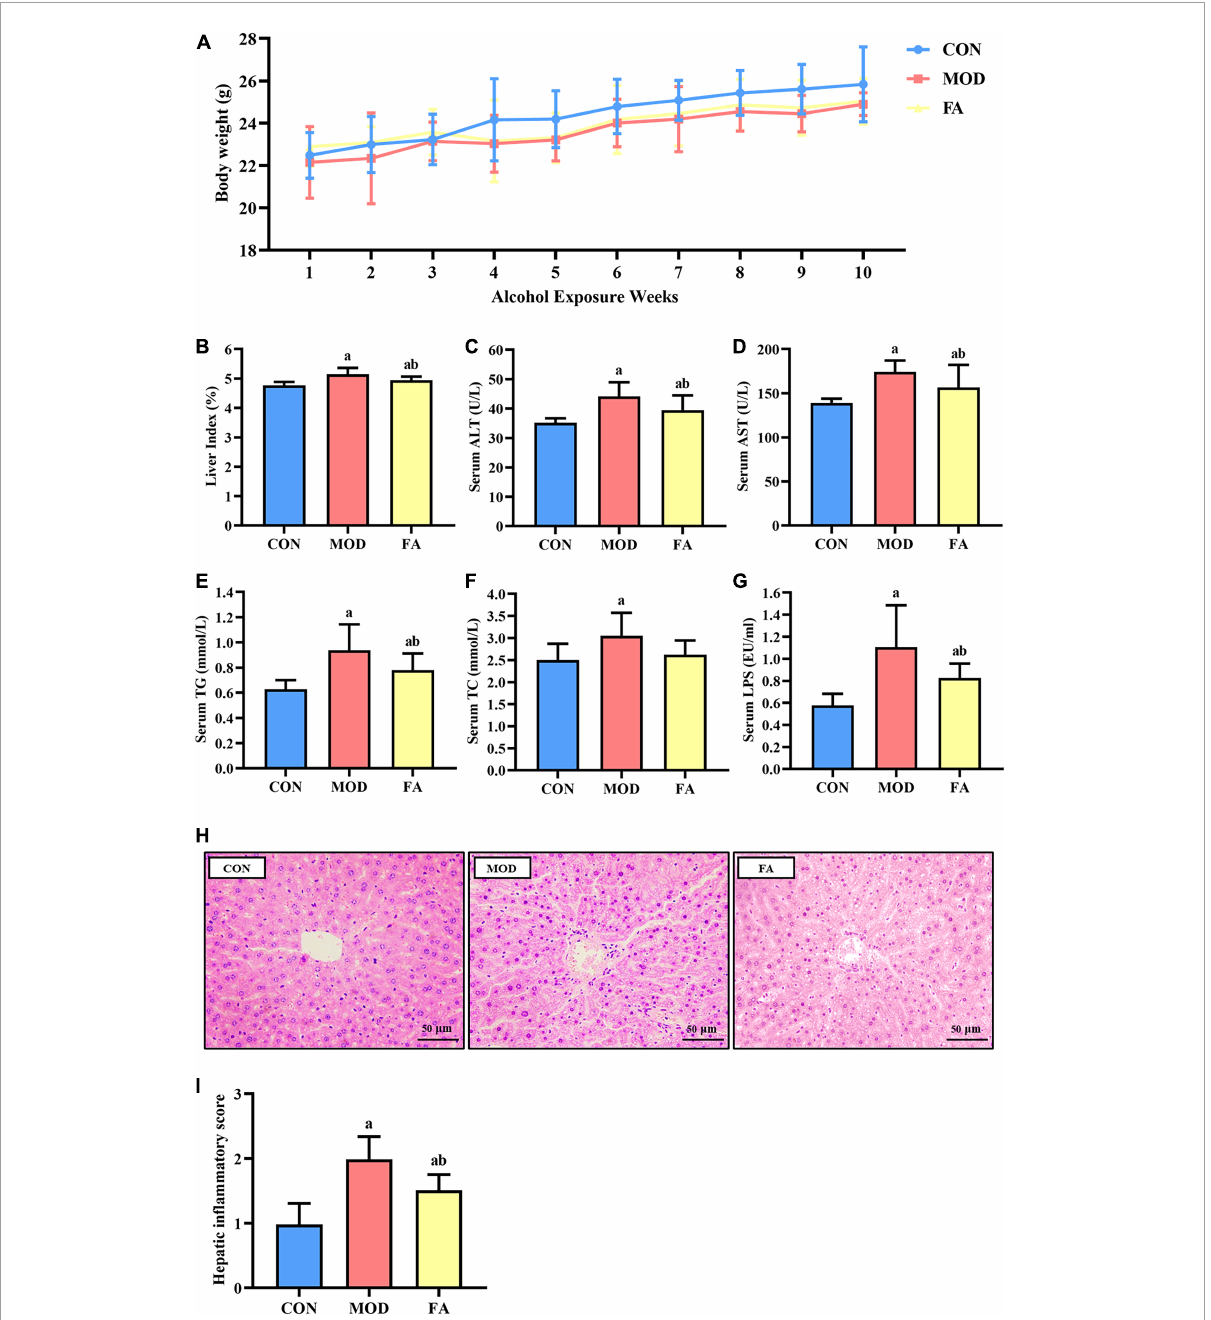
FIGURE2 Effects of folic acid on general parameters of mice. (A) Body weight; (B) liver index; (C) serum ALT; (D) serum AST; (E) serum TG; (F) serum TC; (G) serum LPS; (H) liver histopathology assessed by H&E staining (400 × ) ( n = 3/group); (I) hepatic inflammatory score. Data are presented as mean ± SD ( n = 8/group). a p < 0.05 compared with the CON group; b p < 0.05 compared with the MOD